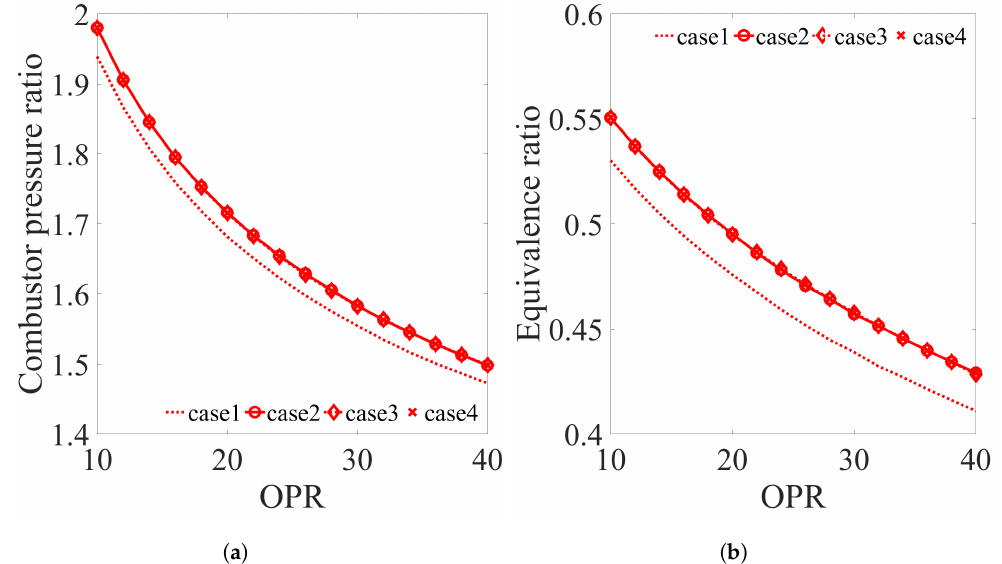
Figure 9. Combustor pressure ratio and equivalence ratio as a function of the cycle pressure ratio for the four versions of the Humphrey cycle presented in Table 3 and a turbine inlet temperature